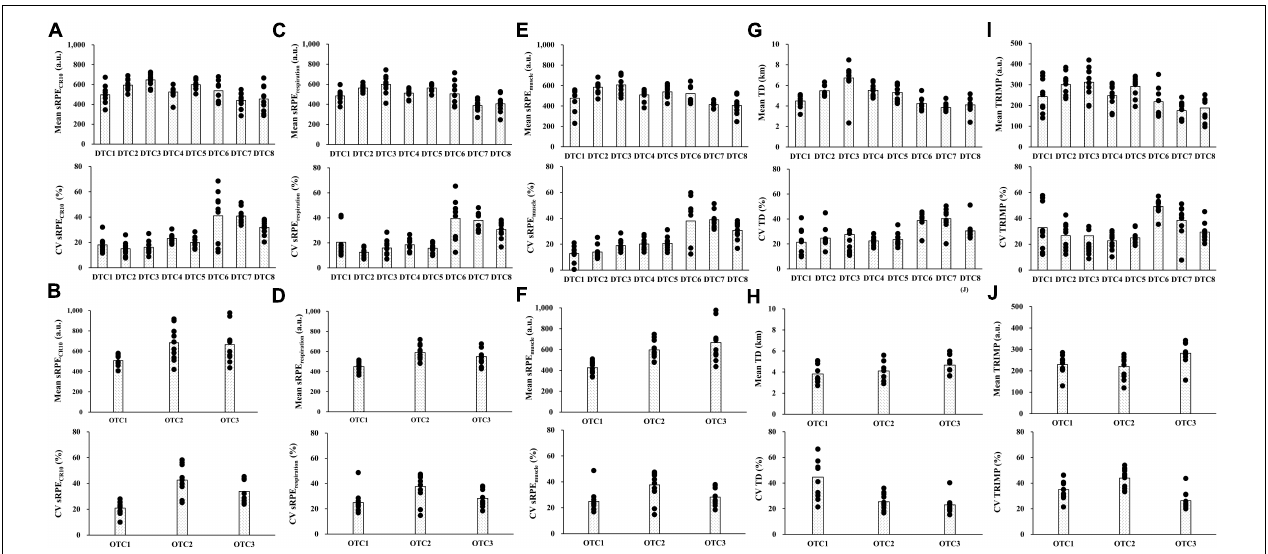
FIGURE 2 | The individual and group values of measured variables across the study period. Scatterplots present individual values during each training camp whereas bar charts present group average during each training camp. (A) Mean and CV sRPE CR10 during the DTC; (B) mean and CV sRPE CR10 during the OTC; (C) mean and CV sRPE respiration during the DTC; (D) mean and CV sRPE respiration during the OTC; (E) mean and CV sRPE muscle during the DTC; (F) mean and CV sRPE muscle during the OTC; (G) mean and CV total distance covered during the DTC; (H) mean and CV total distance covered during the OTC; (I) mean and CV training impulse during the DTC; and (J) mean and CV training impulse during the OTC. sRPE CR10 , session rating of perceived exertion CR10; sRPE respiration